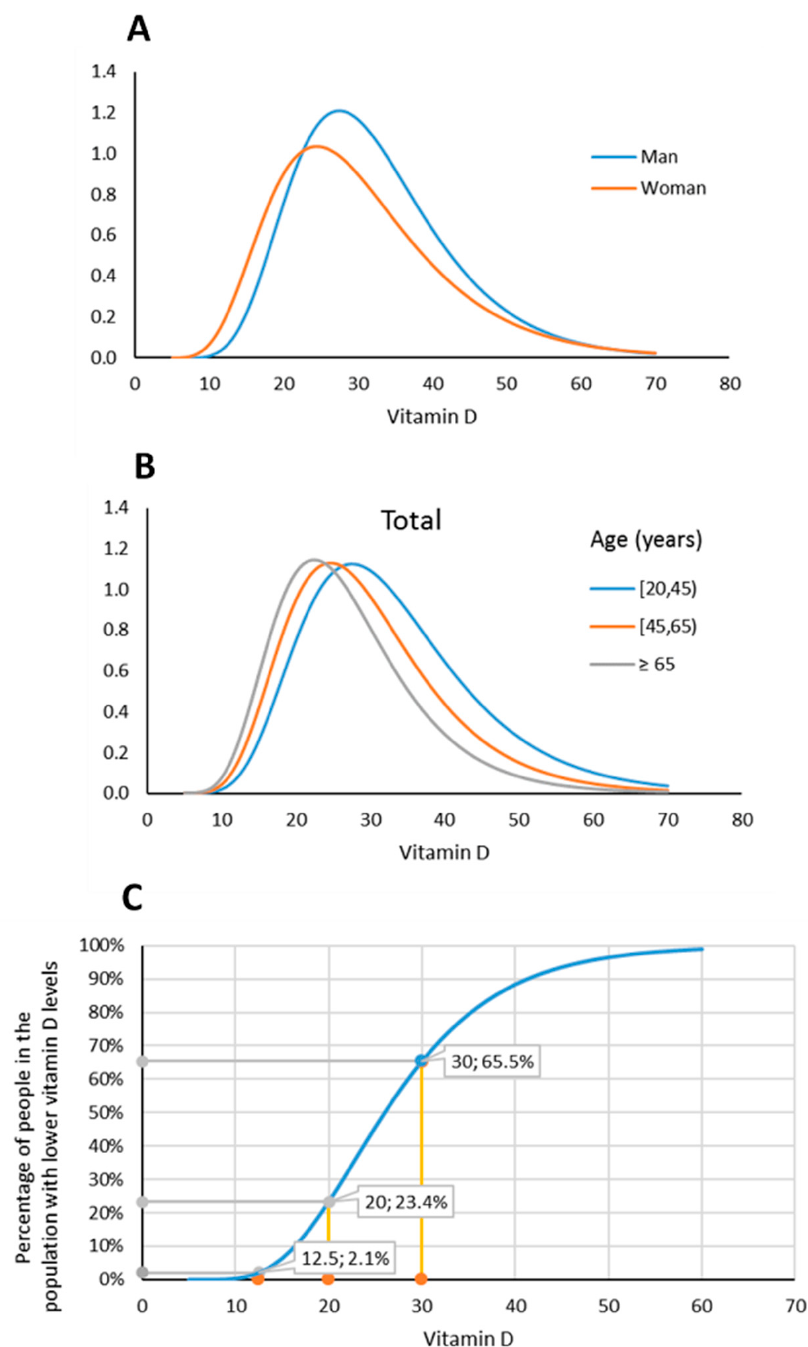
Figure 1. ( A ) Density function of VitD concentration (ng/mL) by gender. ( B ) Density function of VitD concentration (ng/mL) by age groups. ( C ) Distribution of percentiles of VitD concentration. Table 3 shows that 25(OH)D levels were 2.7 units lower in women than in men (95% CI − 4.1; − 1.4, p < 0.001) and 4.4 units higher in 20 to 44 year-olds (95% CI, 2.3; 6.5, p < 0.001) and 2.5 units higher in 45 to 64 year-olds (95% CI 0.4; 4.6, p < 0.019) than in the oldest age group ( ≥ 65 years). VitD levels decreased by 0.298 ng/mL (95% CI, − 0.45; − 0.15, p < 0.001) for each unit of increase in